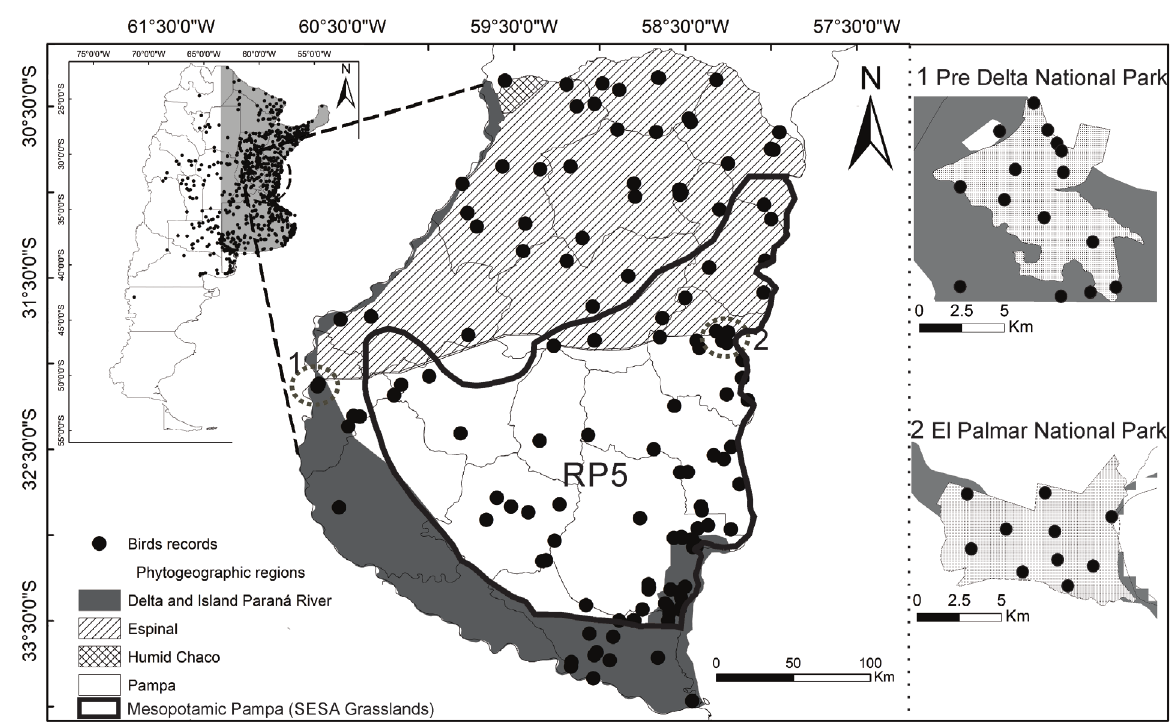
Figure 1. Map of Argentina and the province of Entre Ríos. The background being used is shown on the left upper corner of the map of Argentina (gray area). Black dots represent the records of threatened birds that inhabit Entre Ríos. Numbers (1 and 2) represent the Protected Area